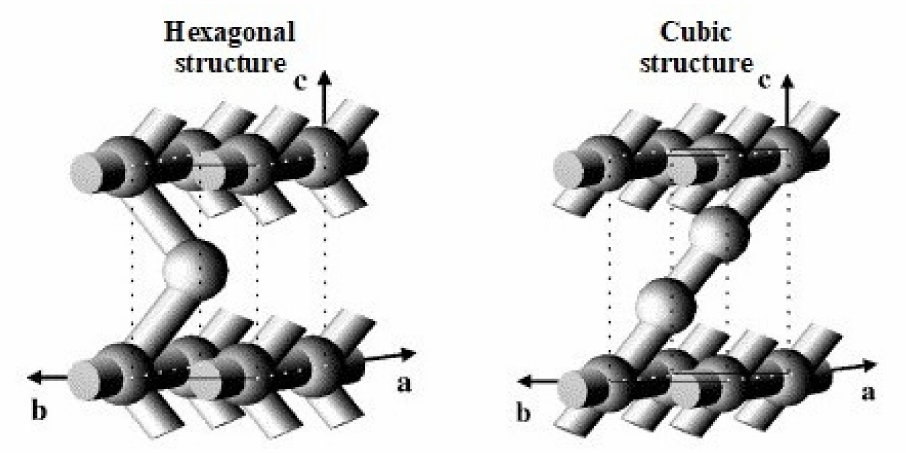
Figure 8. The network of pores in SBA-2. Reprinted with permission from Reference [84] with minor modification. Copyright (2003) Elsevier